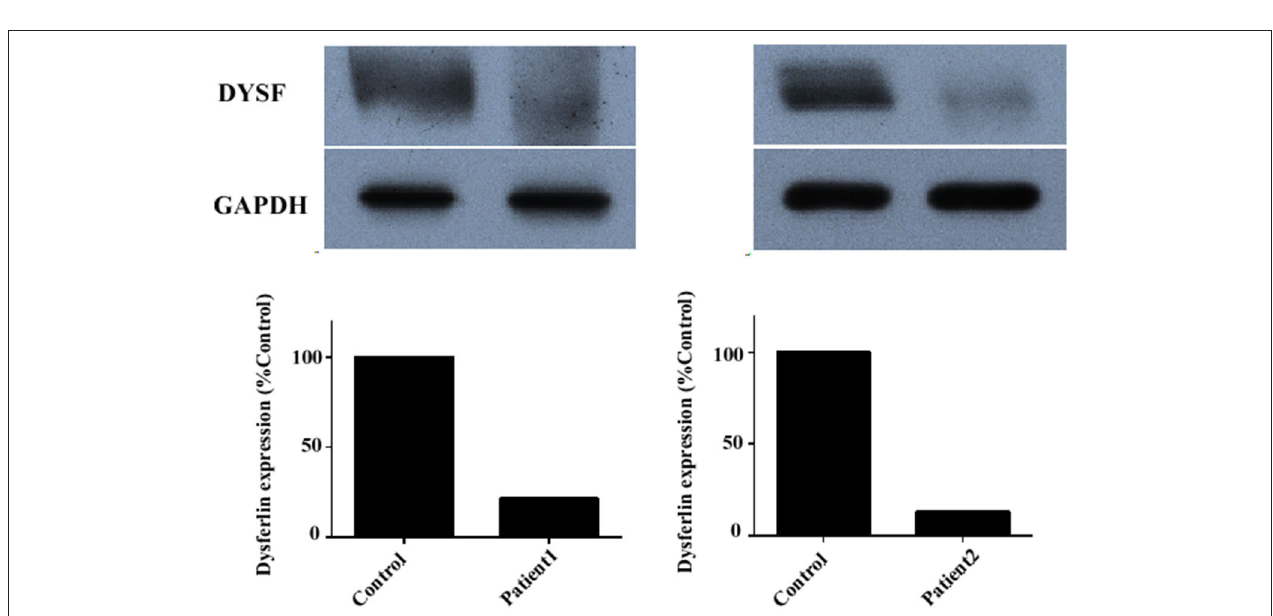
FIGURE 4 | Dysferlin expression in muscle samples of two representative dysferlinopathy patients. Dysferlin expression (upper panel) was significantly reduced in patient 1 and patient 2 compared with healthy individuals. The lower panel shows GAPDH loading control. The data are also graphically presented. The control muscle samples were taken from healthy individuals with informed consent who had undergone open fracture surgery as a result of a car